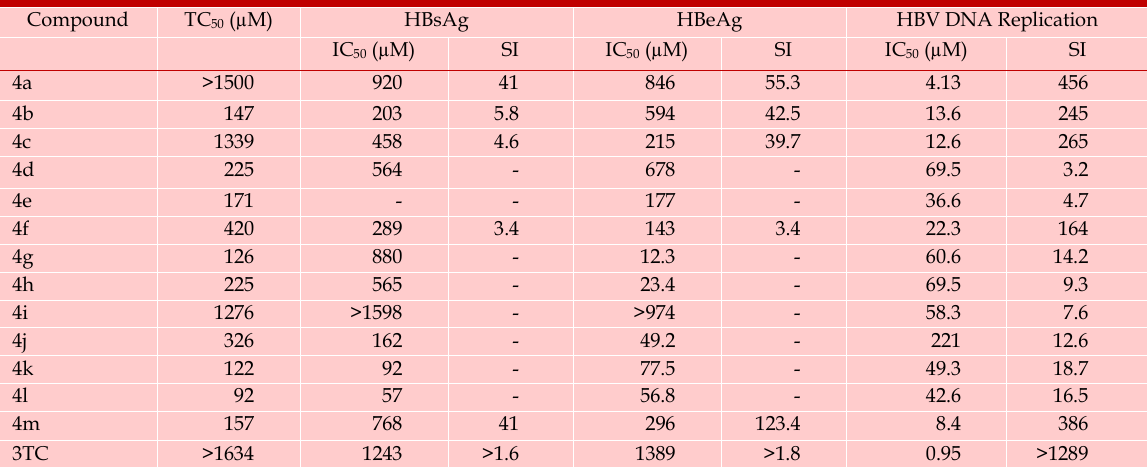
(Cp149:4a = 4:1 or 2:1). At higher concentration (Cp149:4a = 1:2 or 1:4), the increasing continuous spec- trum of void and the decreasing dimers were observed.